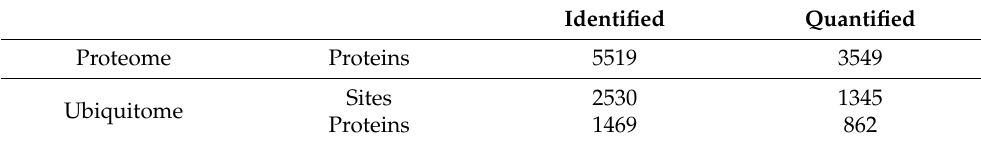
Table 1. Overview of proteins and Kub sites identified and quantified in proteome and ubiquitome data.